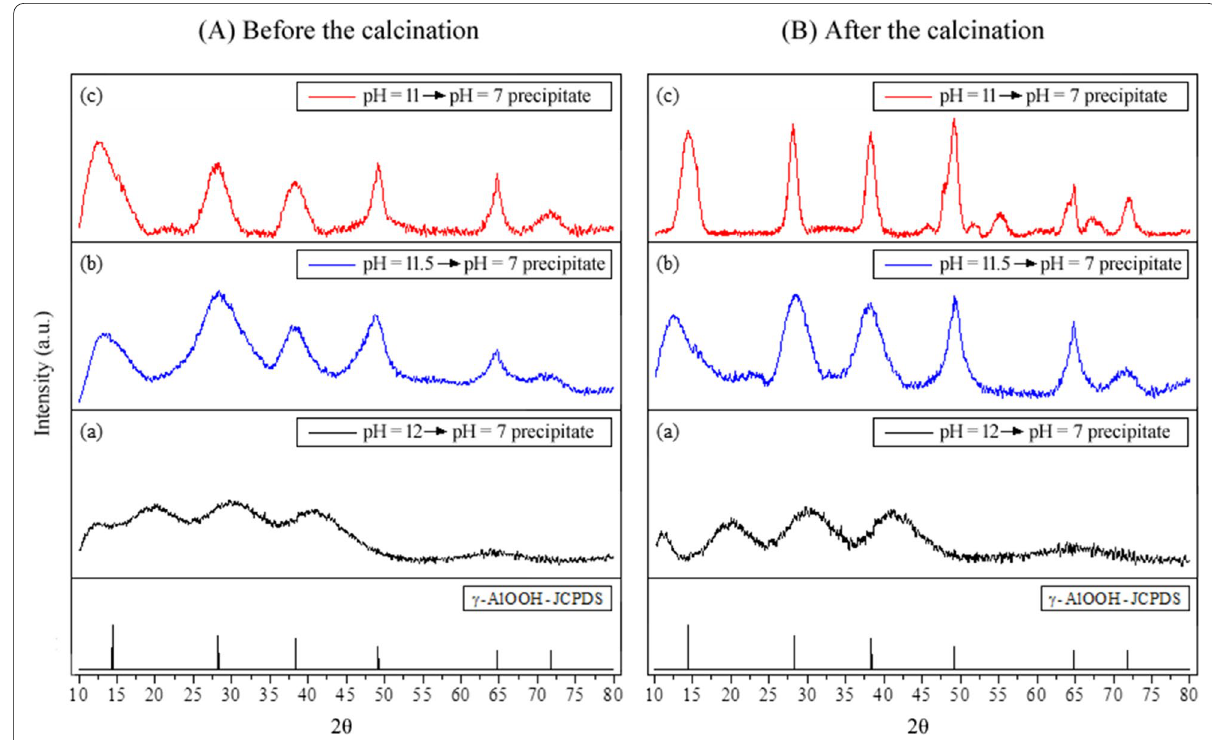
Fig. 8 XRD pattern of the precipitate produced by removing impurities and adjusting to pH